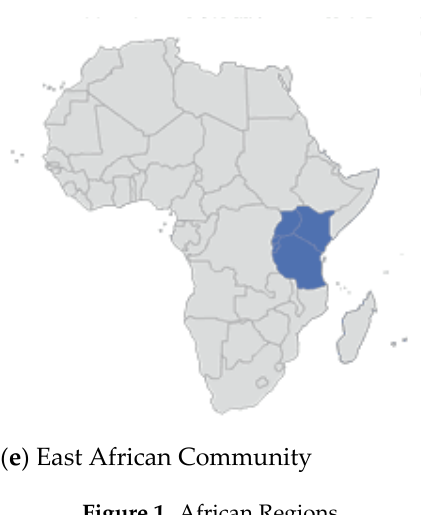
Figure 1. African Regions.